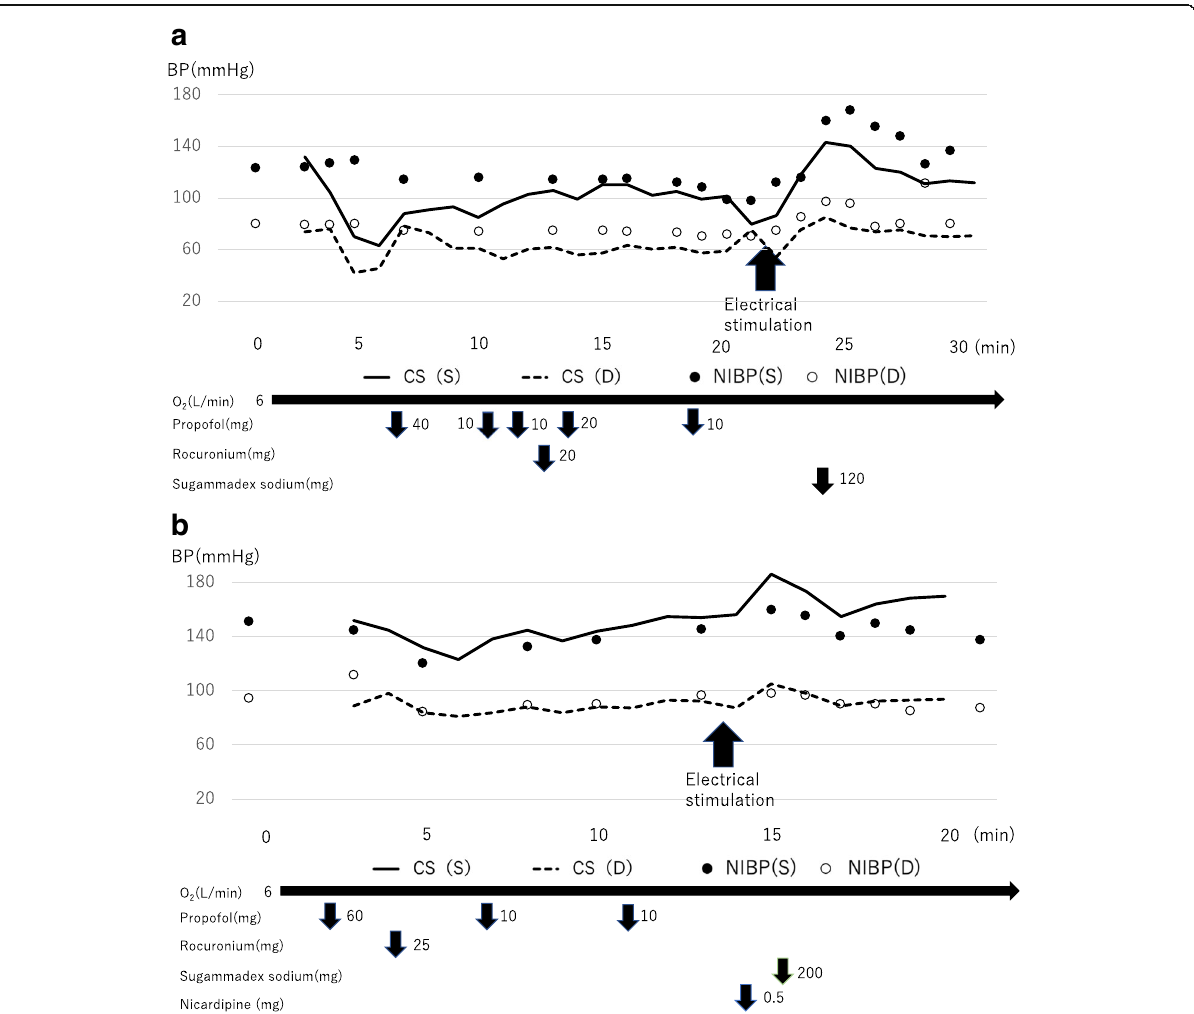
Fig. 2 a The anesthetic chart of first m-ECT. b The anesthetic chart of second m-ECT. There was not much difference between NIBP and BP on the ClearSight ™ system in both charts. CS (S): systolic blood pressure of the ClearSight ™ system. CS (D): diastolic blood pressure of the ClearSight ™ system. NIBP (S): systolic blood pressure of NIBP. NIBP (D): diastolic blood pressure of